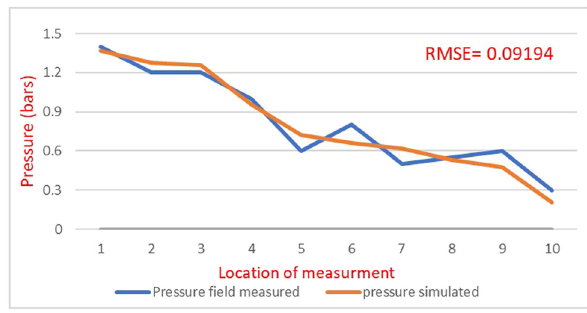
Figure 6: Comparison between simulated and measured pressure heads along di ff erent junctions.